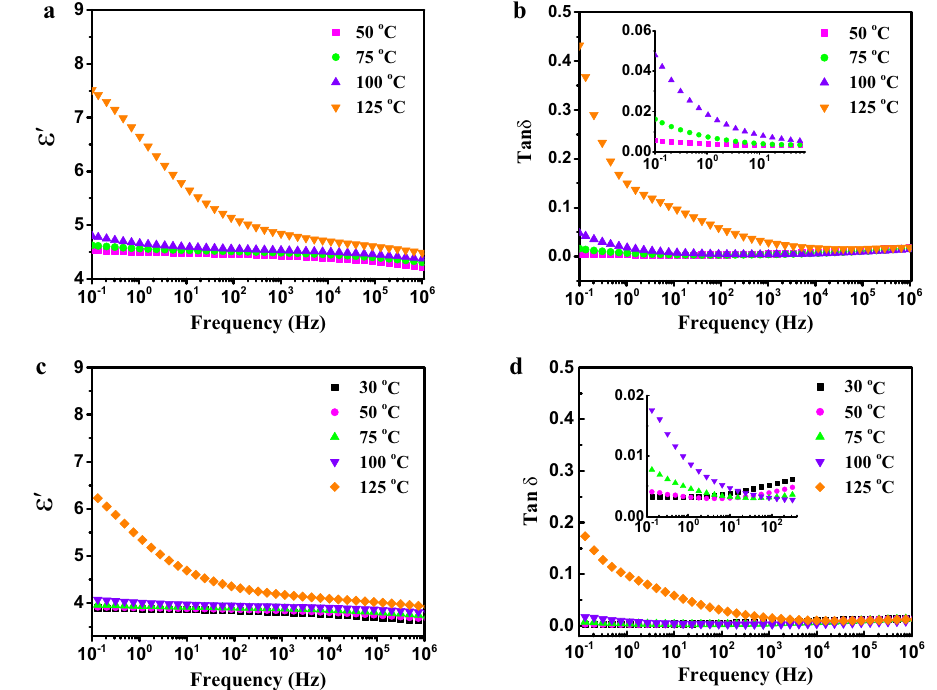
Figure 6. The dependence of dielectric properties for ( a , b ) pure epoxy, and ( c , d ) A6 + B2 at different temperature on